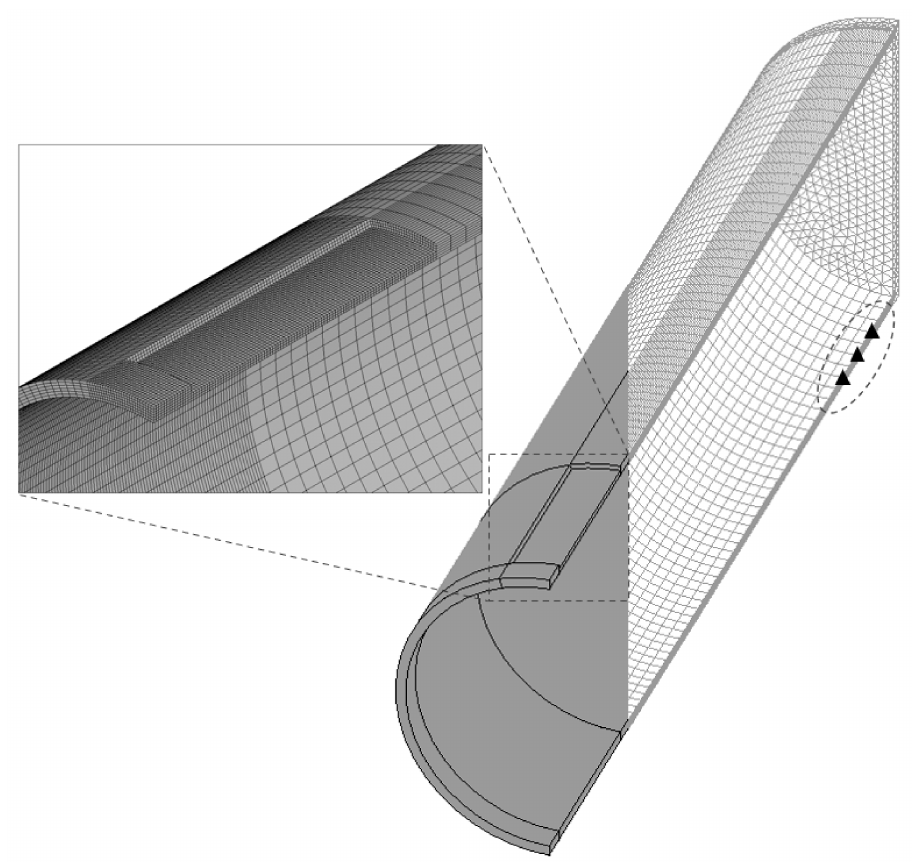
Figure 3. Pipe model with a longitudinally interacting corrosion